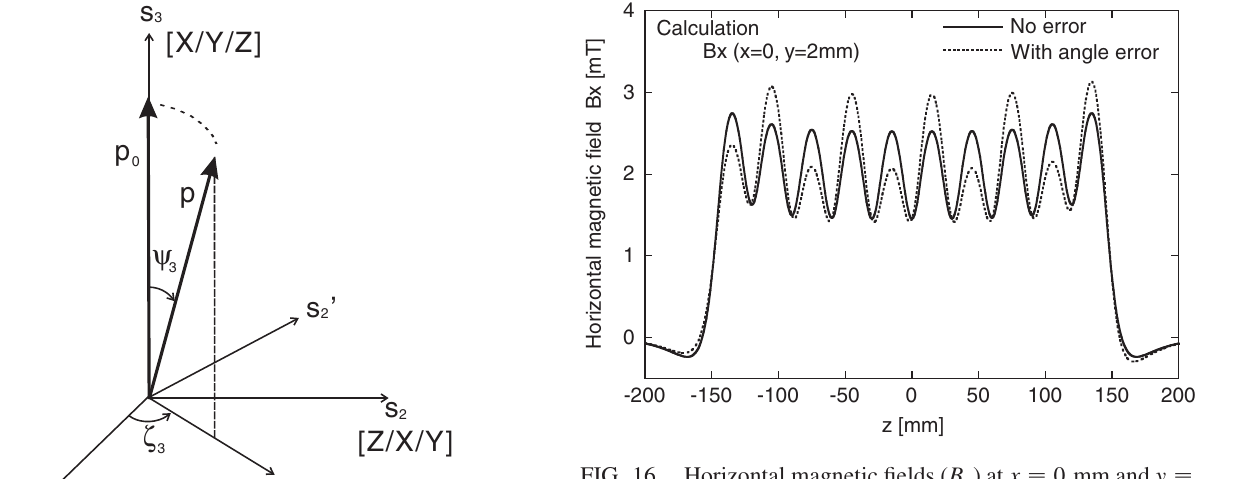
FIG. 16. Horizontal magnetic fields ( B ) at x ¼ 0 mm and y ¼ x 2 mm calculated along the wiggler axis z with no orientation ¼ error (solid lines) and with an orientation error ð (cid:7) x 5